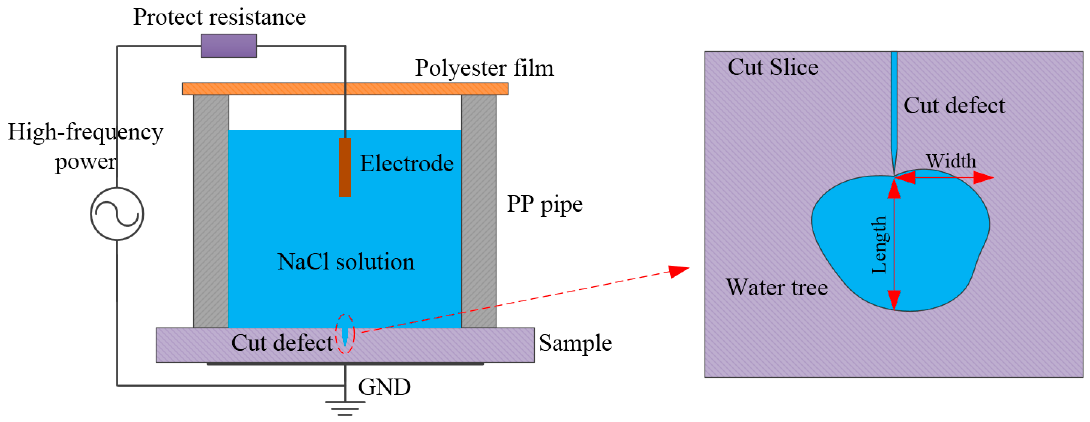
Figure 9. Schematic experimental set-up of water-tree initiation with water blade electrode.